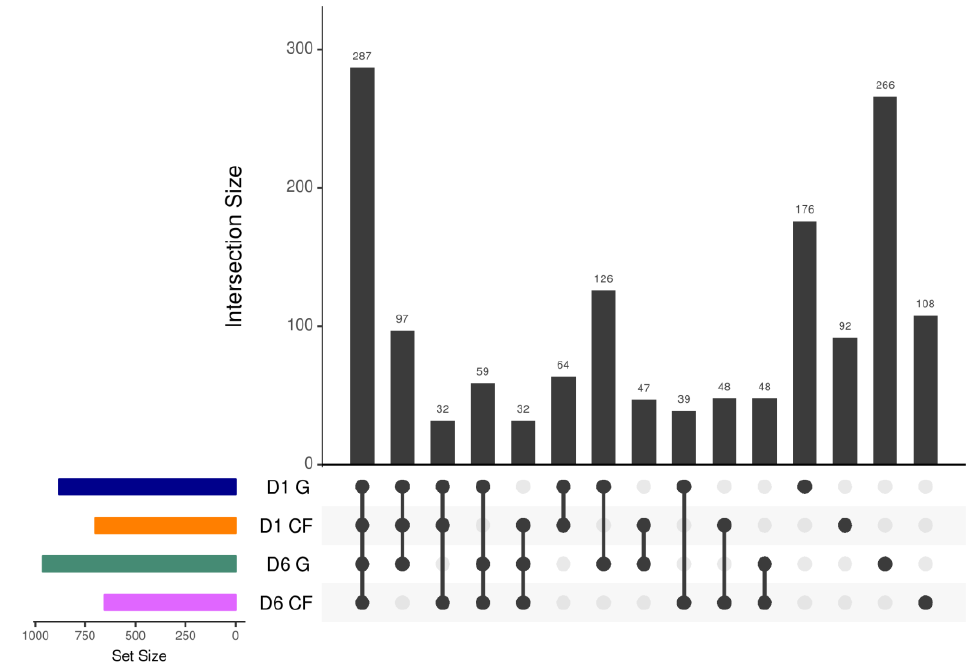
Figure 9. UpSet plot of intersections between sets of bacterial genes induced (family-wise error rate <0.05, log 2-fold change >2) by chitosan-dressing treatment compared with gauze-dressing treatment. The bar chart on the left indicates the total number of upregulated bacterial genes for each dressing. The upper bar chart indicates the intersection size between sets of bacterial genes upregulated with one or more dressings. Dark connected dots in the bottom panel represent the substrates considered for each intersection (D1 = day 1; D6 = day 6; G = gauze; CF = chitosan).